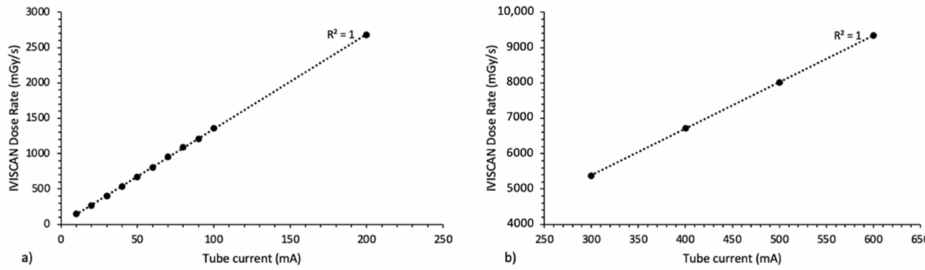
Figure 8. IVISCAN ® response in air kerma rate for the whole range of X-ray tube current for ( a ) small focal spot and ( b ) large focal spot, on Canon Aquilion ONE TM